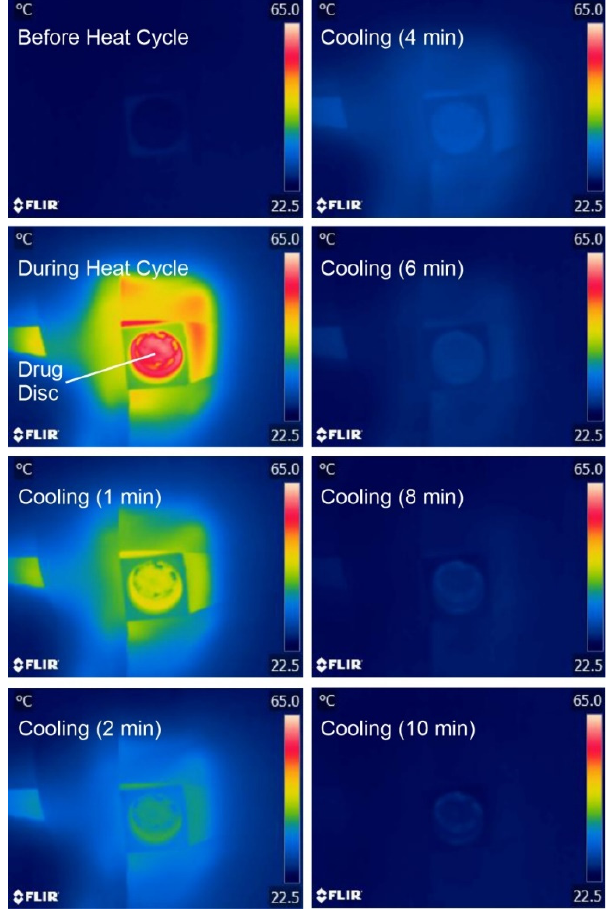
Figure 7. Thermal imaging of the drug film layer before, during, and after onset of heating at the LIG patch assembly.